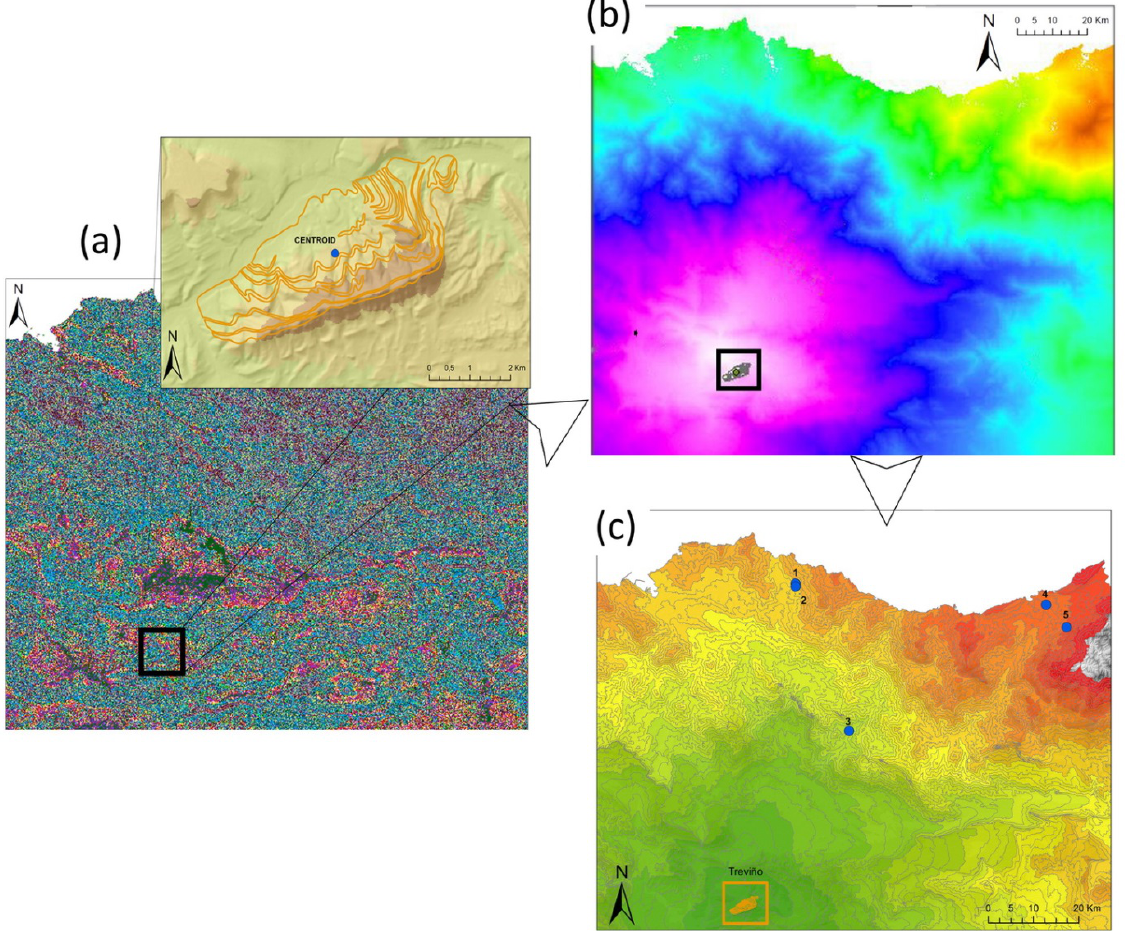
Figure 3. Methodological diagram showing the procedure for getting accumulated cost maps from a given outcrop: a) slope map reclassified according to the reclassification curve, with detail of the centroid of the outcrop of Treviño; b) accumulated cost map from the outcrop of Treviño; c) accumulated cost map from the outcrop of Treviño reclassified in CU. Scale bar in maps a to c is 20 km, and is 2 km in the inset